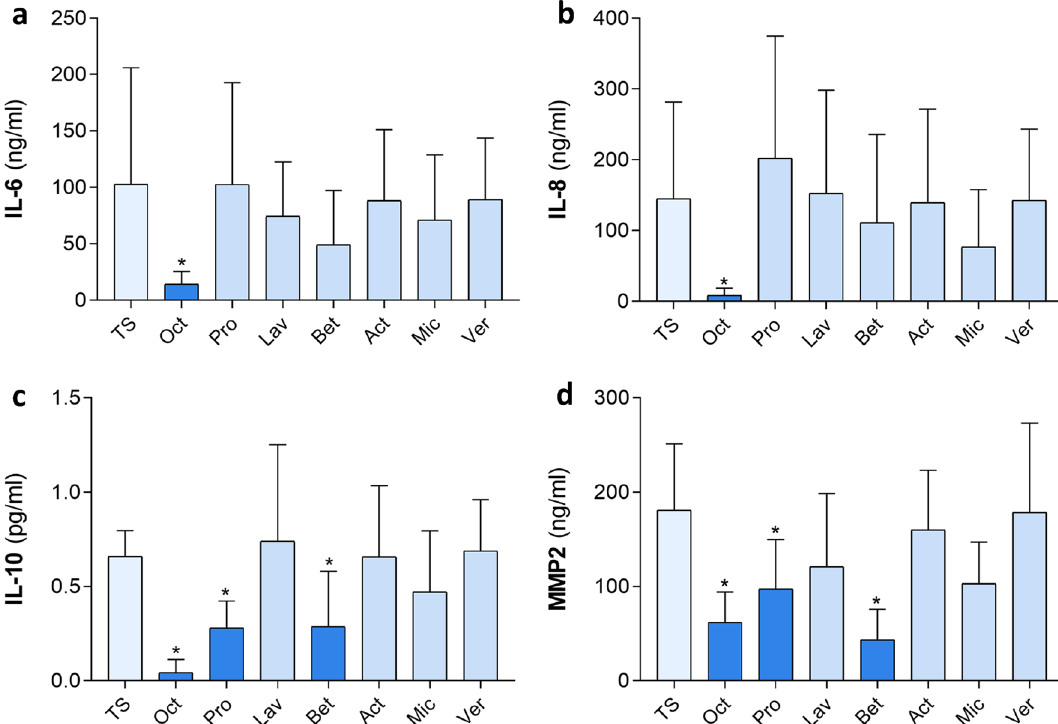
Figure 1. Quantification of cytokines in superficially wounded ex vivo skin treated with commercially available wound gels. Shown are ( a ) IL-6, ( b ) IL-8, ( c ) IL-10, ( d ) MMP2 concentration levels in culture supernatants of 48 h cultured human tape-stripped (TS) skin biopsies topically treated with indicated wound gels as well as a TS untreated control. Samples were analysed in duplicates with an enzyme-linked immunosorbent assay (ELISA). Data is presented as a mean ± standard deviation. A Wilcoxon matched-pairs signed rank test was performed with GraphPad Prism 9.3.1. *p ≤ 0.05; n = 6, female donors, location: abdomen, age range: 20–45 years (panel 1).